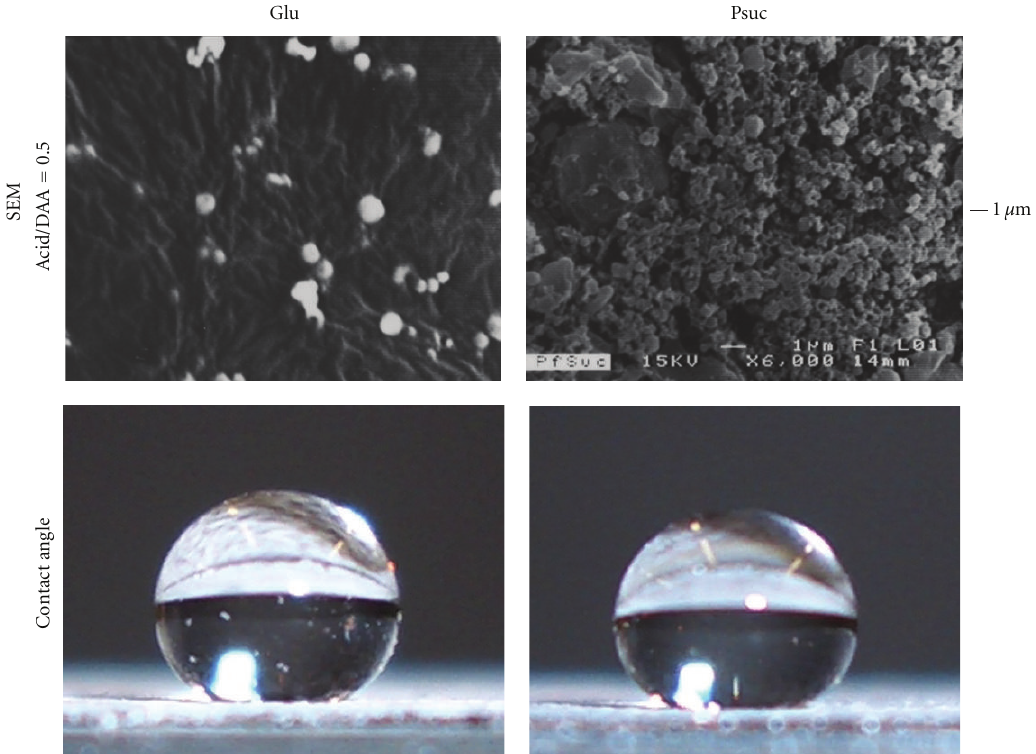
Figure 17: SEM images of the particles produced by the copolymer in the presence of Glu and Psuc, and photographs of water droplets placed on the surface coated with the